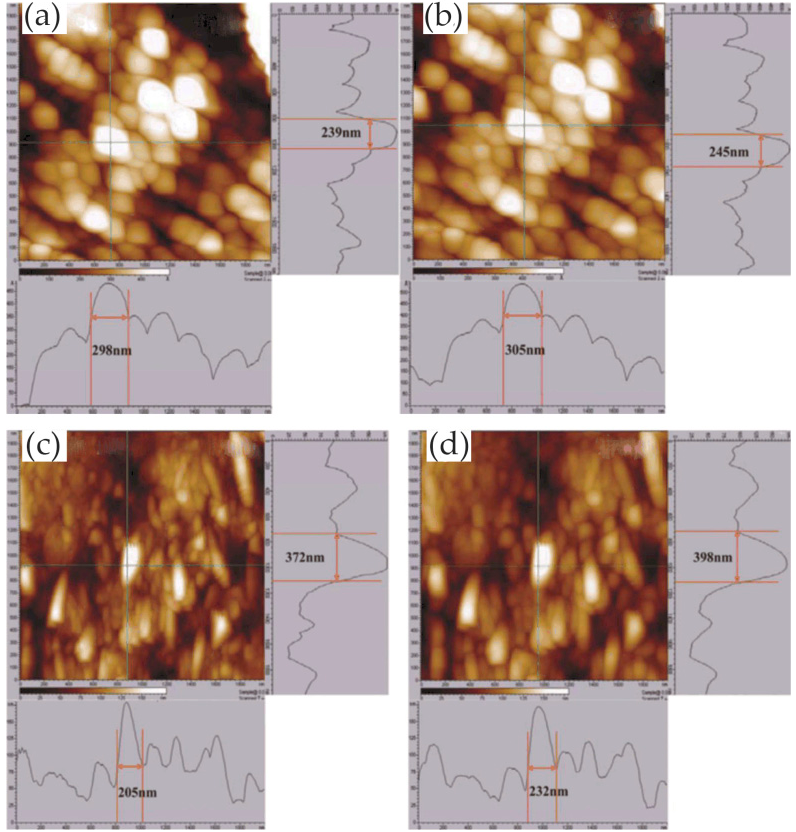
Figure 32. In situ AFM images of coarse crystal (CC) 304L stainless steel ( a , b ) and a NC thin film ( c , d ) (scale 2 μ m × 2 μ m) in the growth stage of a passive film under anodic polarization in 0.05 M H 2 SO 4 + 0.2 M NaCl solution after passivation of 6 min ( a , c ) and 12 min ( b , d ). Reprinted with permission from Reference [72]; copyright 2012 Electrochemical Society.